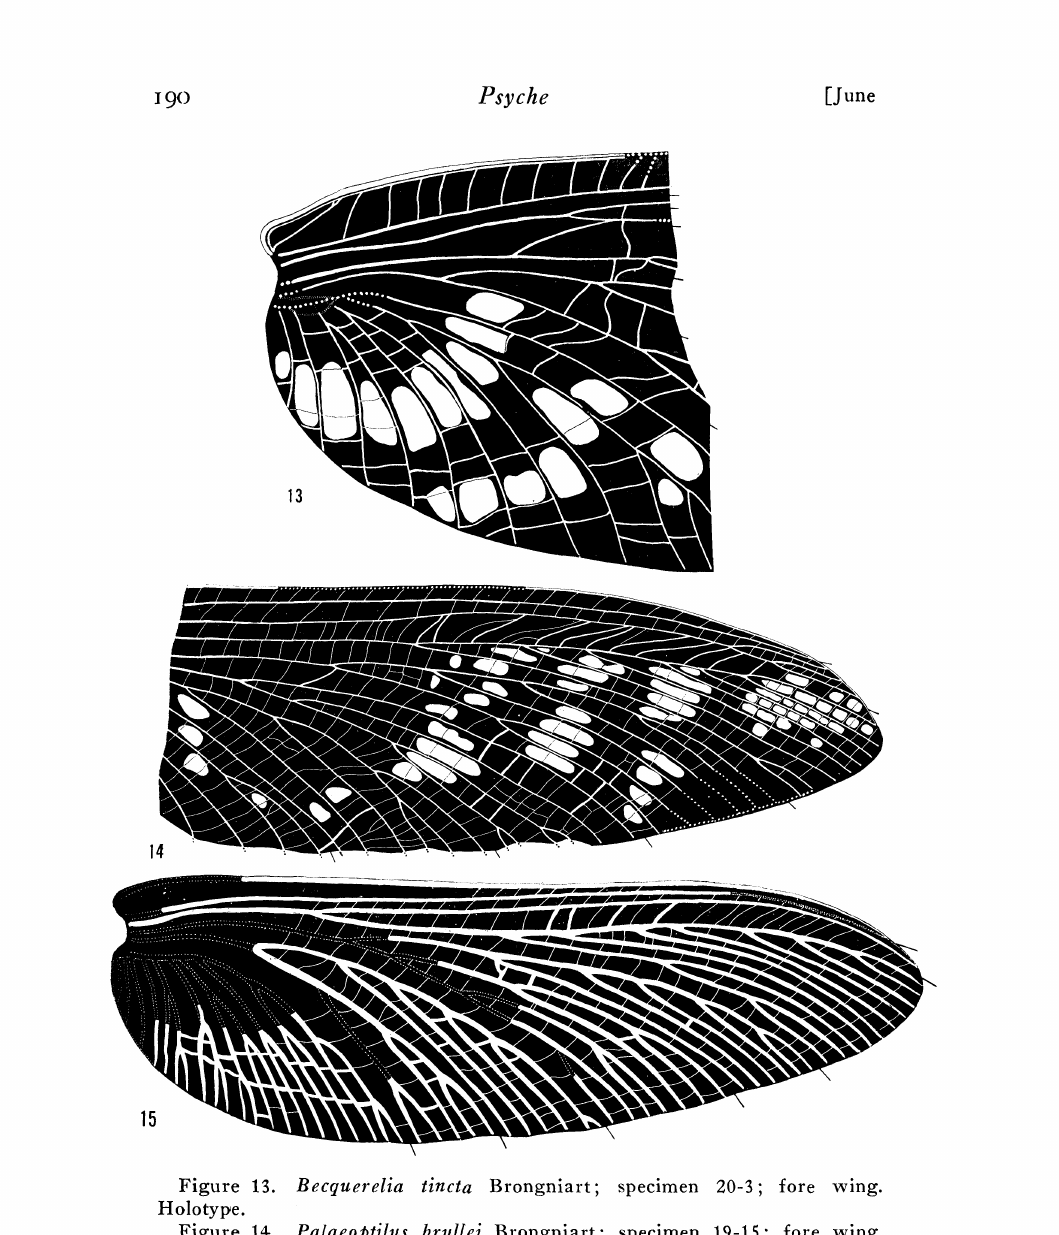
Figure 13. Becquerelia tincta Brongniart; specimen 20-3; fore wing. Holotype. Figure 14. Palaeoptilus brullei Brongniart; specimen 19-15; fore wing. Holotype. Figure 15. Epitethe meunieri (Brongniart); specimen 19-5; hind wing.